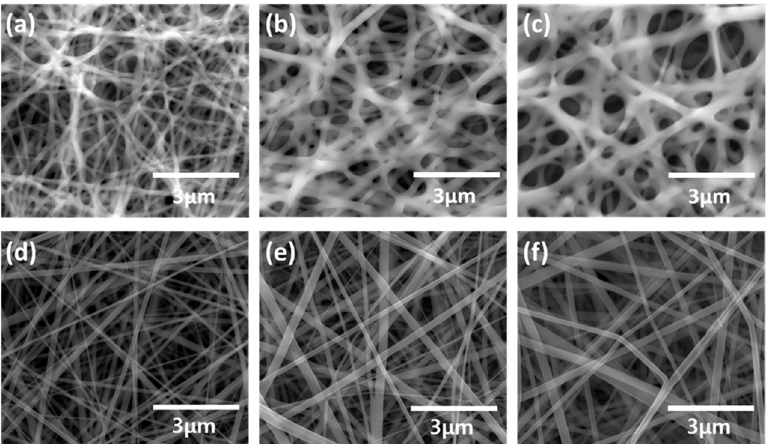
Figure 3. Field emission-scanning electron microscopes (FE-SEM) images of as-spun and calcined Ni 0.5 Zn 0.5 Fe 2 O 4 nanofibers obtained from various samples: ( a ) As-spun nanofibers of sample A, ( b ) As-spun nanofibers of sample B, ( c ) As-spun nanofibers of sample C, ( d ) Calcined Ni 0.5 Zn 0.5 Fe 2 O 4 nanofibers of sample A, ( e ) Calcined Ni 0.5 Zn 0.5 Fe 2 O 4 nanofibers of sample B, and ( d ) Calcined Ni 0.5 Zn 0.5 Fe 2 O 4 nanofibers of sample C.